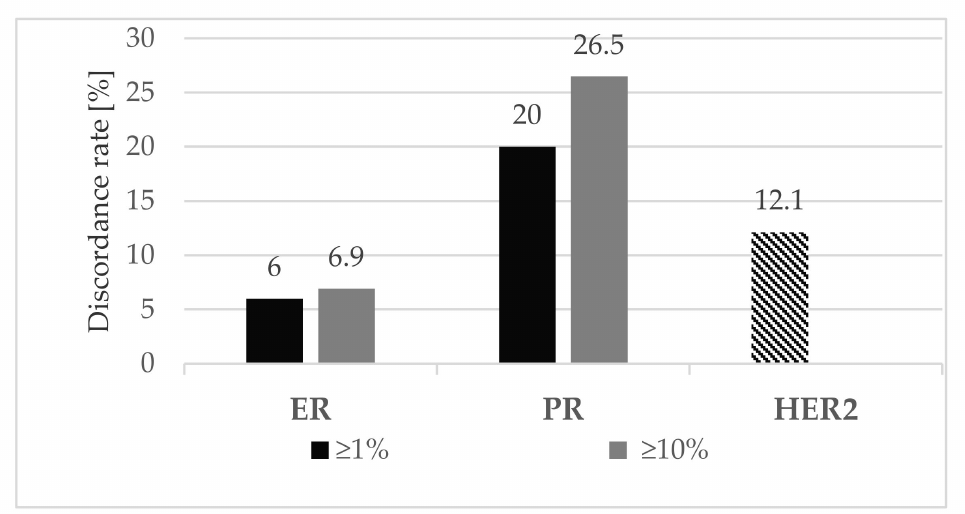
Figure 2. Discordance rates of ER, PR (using cut-offs ≥ 1% and ≥ 10%) and HER2 in LNM compared with t-CNB. The discordance rates between axillary LNM and t-CNB were 6% and 6.9%, respectively for ER, 20% and 26.5%, respectively for PR in the ≥ 1% and ≥ 10% groups, and 12.1% for HER2. 3.3. Analysis of Intrinsic Subtype Discordance between LNM and t-CNB (Using ≥ 1% Cut-Off Value)